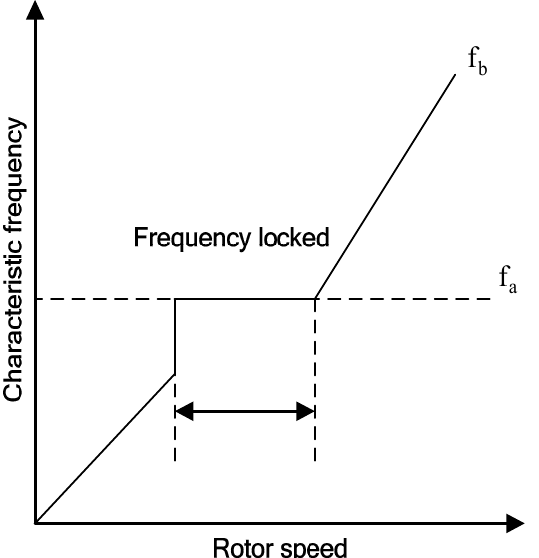
Figure 6. Correspondence between characteristic frequency of noise spectrum and rotor speed.